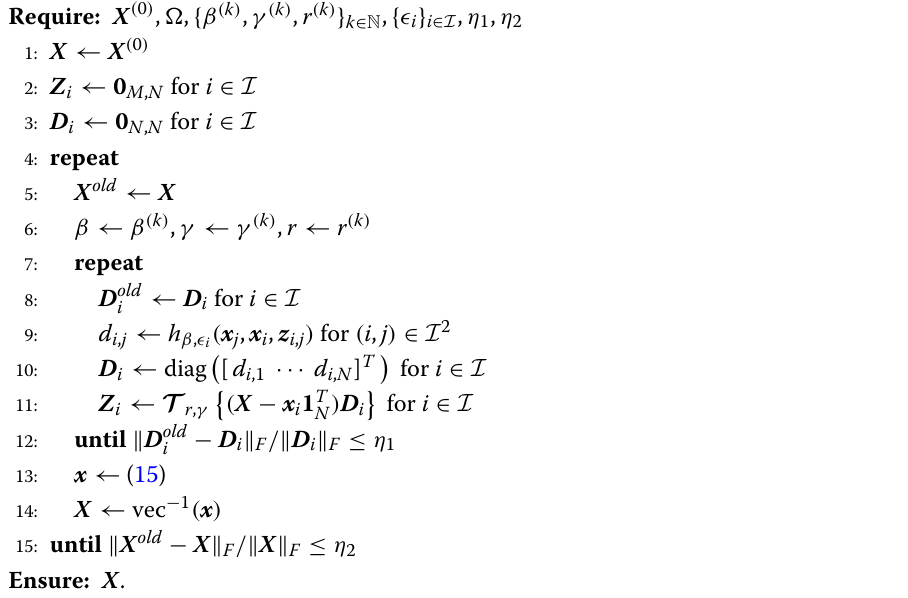
Algorithm 1 LLRA algorithm for matrix completion with given r